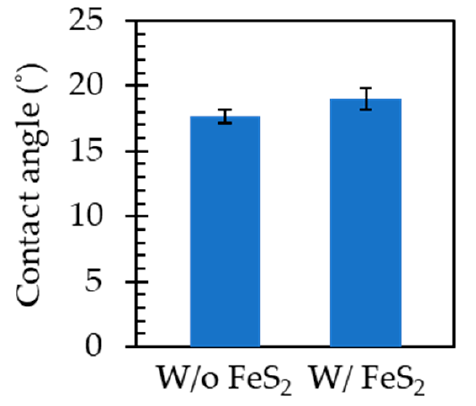
Figure 10. The contact angle of sphalerite in the absence and presence of pyrite.